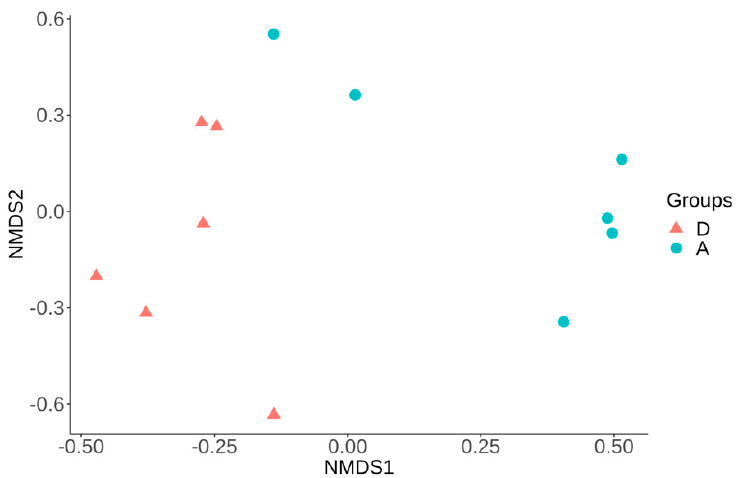
Figure 3. Non-metric multidimensional scaling (NMDS) using Bray–Curtis distance matrix showing significant difference ( p < 0.05, R 2 = 0.25) in the fecal microbiota structure between groups A and D at Day 4 (same results were observed at Day 7 and Day 36 (Figure S2)). A —challenged untreated group. D —unchallenged untreated group.